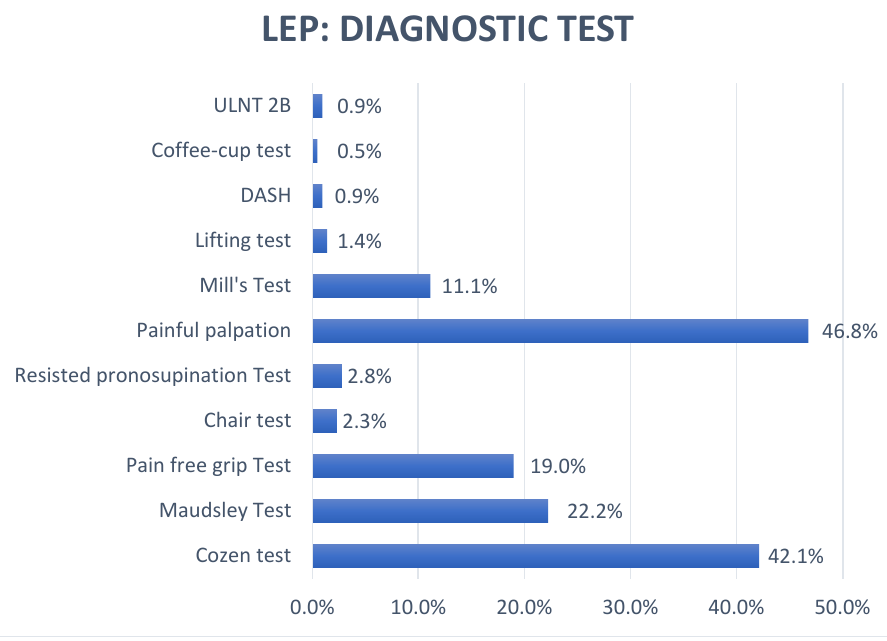
Figure 4. Onset of symptom criteria for LEP reported in the selected studies. 3.6. Etiopathogenetic Terms in LEP In the 25 SRs the symptomatology was described through the terms “tennis elbow”, “lateral epicondylitis”, “lateral elbow pain”, “lateral elbow tendinopathy”, “lateral epi- condylalgia”, “epicondylosis” and “epicondilopathy” [21–45]. In the 227 RCTs collected through the selection of the 24 SRs, 11 different terms were recorded describing the same LEP clinical condition. The most used term was “lateral ep- icondylitis” (51.6%), followed by “tennis elbow” (28.1%) and “lateral epicondylalgia” (9.4%). Further terms used to define LEP from an etiopathological point of view were “ep- icondylalgia” (3.6%), “epicondylosis” (1.0%) “lateral elbow tendinopathy” (2.1%), “chronic elbow tendinosis” (0.5%), “common extensor tendinosis” (1.6%), “lateral